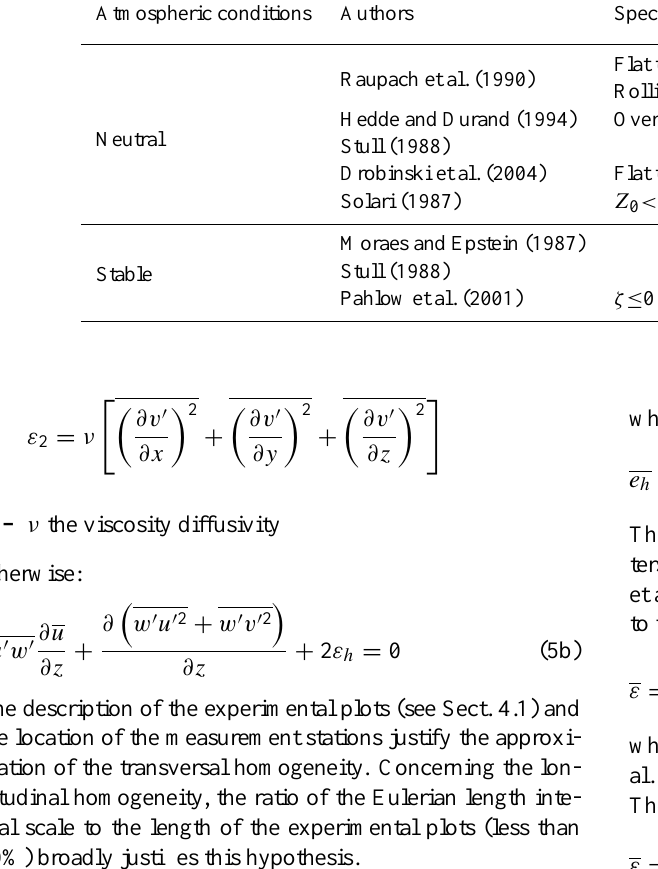
Table 1. Variances of the horizontal wind components in neutral and stable conditions in the ASL, according to authors. Atmospheric conditions Authors